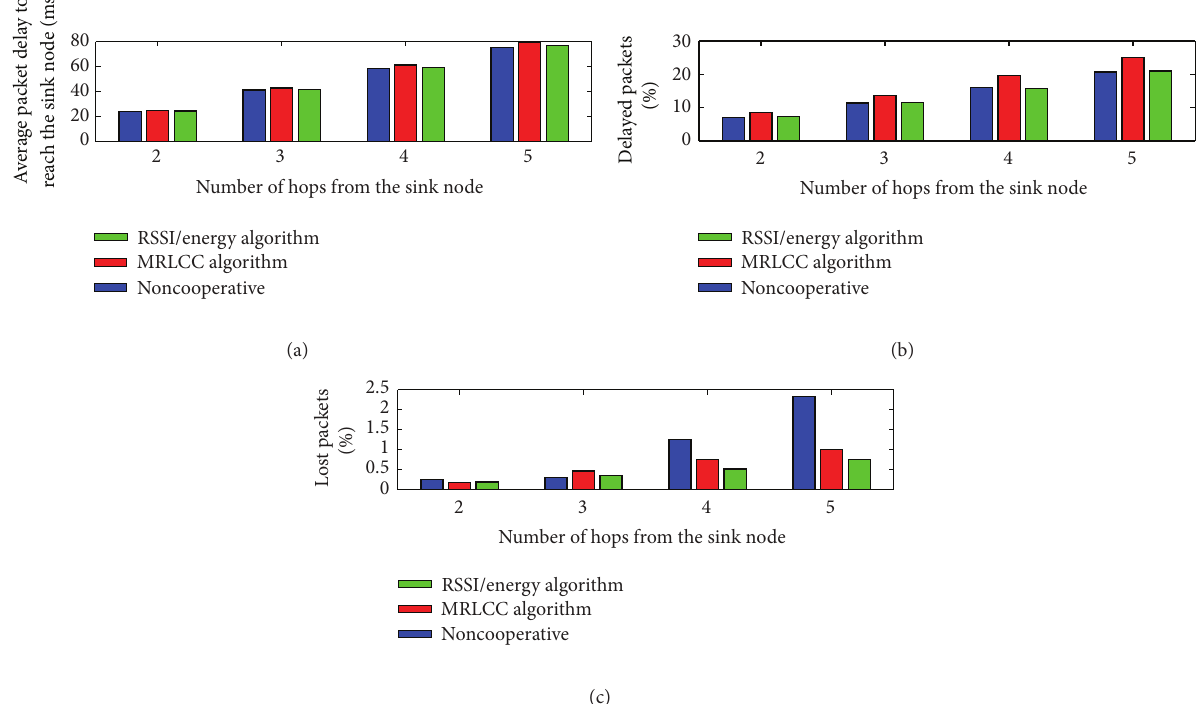
Figure 5: Average delay to the sink, percentage of delayed packets, and percentage of lost packets by averaging on the number of nodes being away with the same number of hops from the sink node.